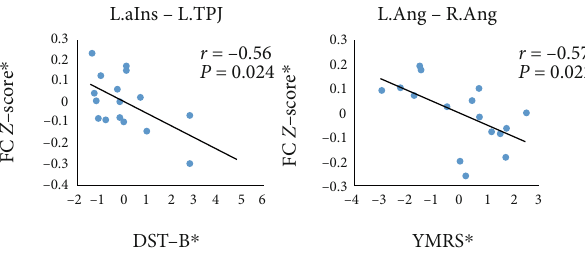
Figure 5: The relationship between the functional connectivity and psychological and clinical variables. ∗ represents the adjusted values controlling for the in fl uence of the age, gender, and education years by the linear regression